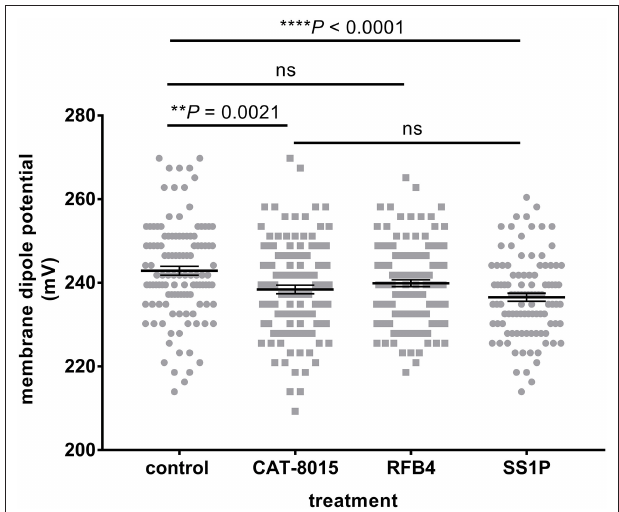
FIGURE 5 | Interaction of CAT-8015 with RBCs is via its toxin component, PE38. Representative dot plot of changes in the MDP of Di-8-ANEPPS-labelled RBCs from healthy individuals ( n = 3) after treatment with buffer only (control) or buffer containing CAT-8015, RFB4 (an anti-CD22 monoclonal antibody to mimic the antibody component of CAT-8015) or SS1P (an anti-mesothelin Pseudomonas exotoxin A-based immunotoxin to mimic the toxin component of CAT-8015). Each dot represents an individual cell within a population of RBCs. At least 100 cells per treatment were analysed. Statistical significance was determined using Ordinary One-Way ANOVA, Dunnett multiple comparison test. Significant differences are indicated (** p = 0.0021, **** p < 0.0001), ns, not significant. One representative experiment out of three is